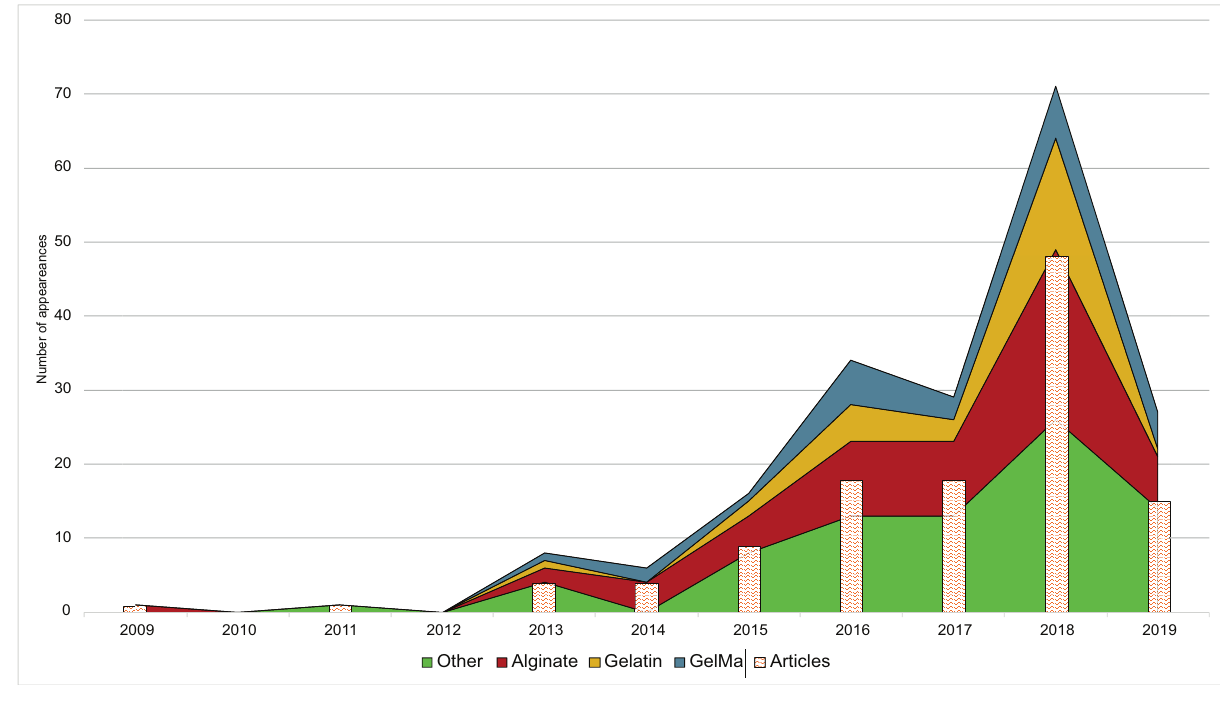
FIGURE 3 | Research trend in hydrogels for bioprinting using a bar chart ( papers per year ) combined with a stacked area chart ( total uses of a material per year ). The three most used materials (alginate, gelatin, and GelMA) are shown individually while the rest of materials are grouped in the category “other.” It is important to note that some materials are used in more than one paper, so some stacked areas overtake its corresponding bar